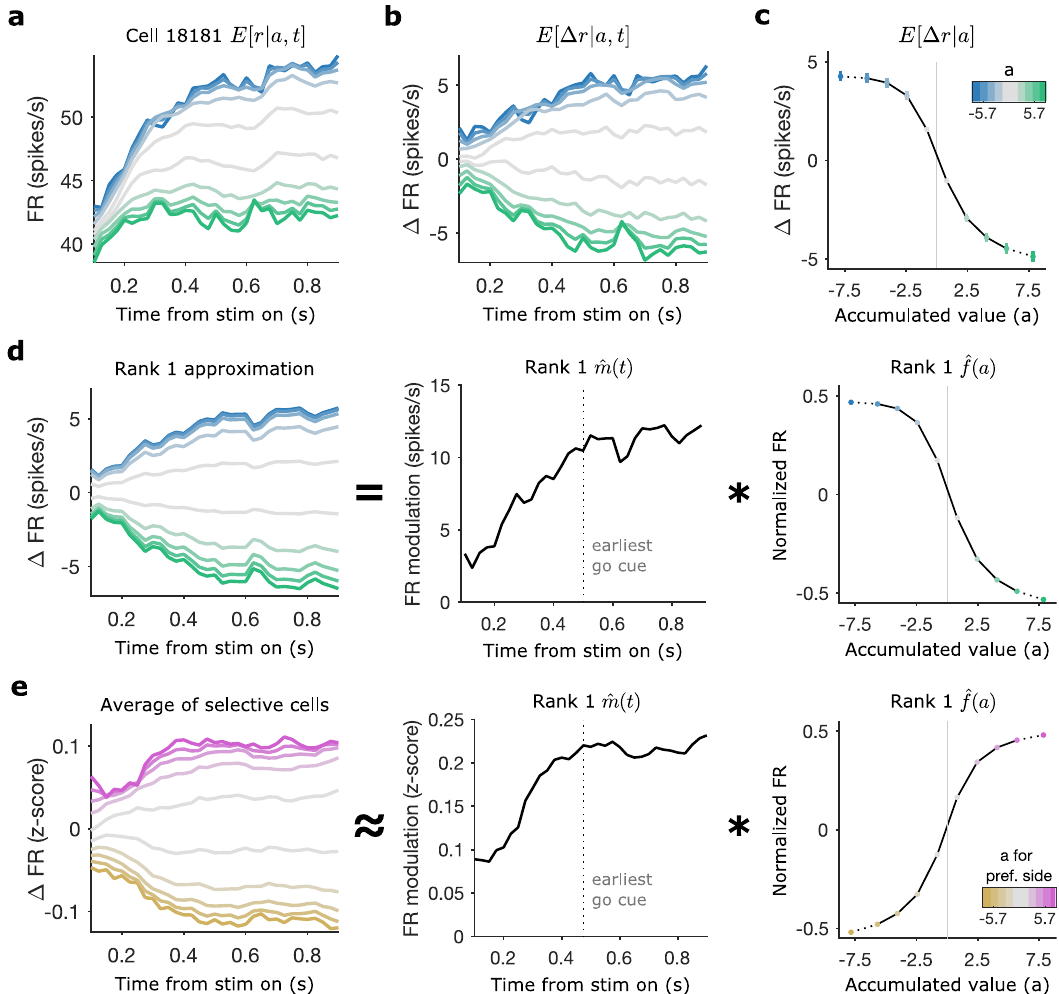
Fig. 3 FOF neurons encode the accumulated evidence throughout the trial despite a changing environment. a Firing rate map as a function of accumulated evidence and time for an example neuron. Colors indicate accumulated evidence value with the same colors as in ( b ) and ( c ). b Residual rate map in which the mean temporal trajectory is subtracted. c Tuning curve averaged over time ( n = 33 time bins). Points indicate mean (±s.e.m.) across time of the change in fi ring rate relative to temporal average as a function of accumulated evidence value a . d Rank 1 approximation of the residual rate map E [ Δ r ∣ a , t ] from ( b ). The approximation (left) is equal to the outer product of a modulation over time ^ m ð t Þ (middle) and a tuning curve ^ r ð a Þ (right). e Average residual z scored fi ring rate map (left). This plot is produced by averaging over the residual z scored fi ring rate map of all pre-movement side-selective cells. This map is approximated by the outer product of a modulation curve (middle) and a tuning curve (right). Source data are provided as a Source Data fi